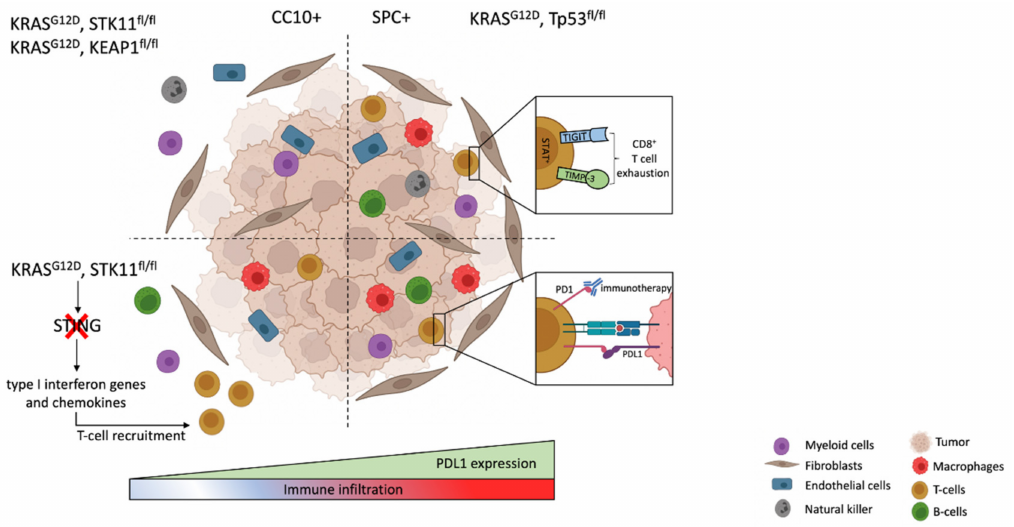
Figure 3. Cell of origin determines the immune microenvironment (created with BioRender.com, accessed on 15 February